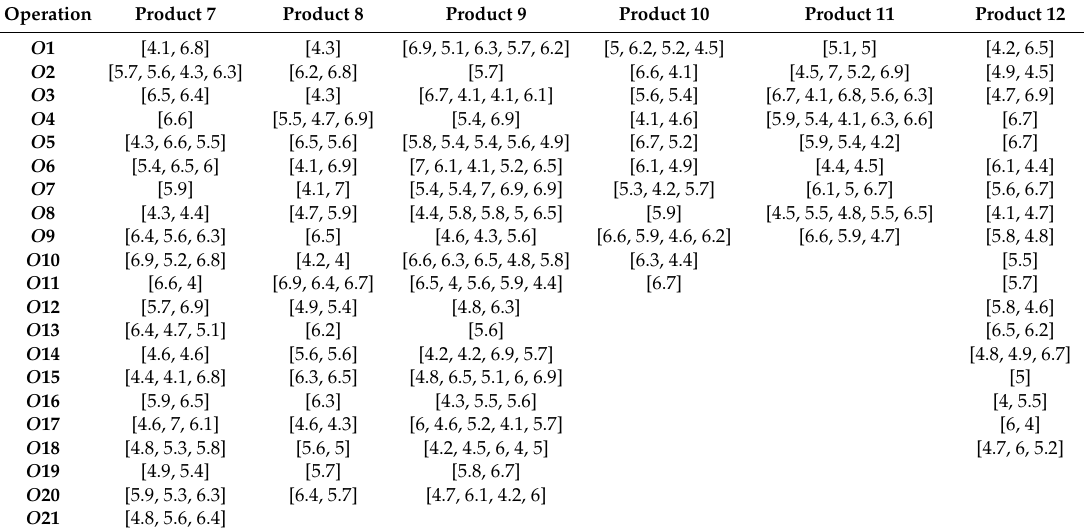
Table A2. Working power for the operations processed on machines in case 2.